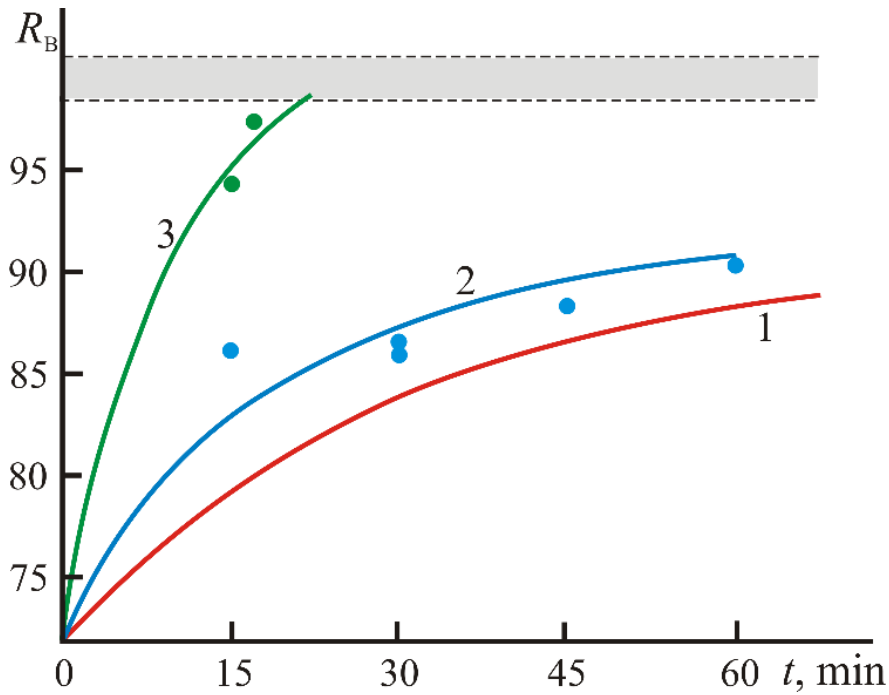
Figure 8. Dispersion strengthening curves for KhN80T alloy for different regimes of ageing: standard (static) ageing at 700 ◦ C (1), 700 ◦ C with UST at σ 0 = 25 MPa (2), 700 ◦ C with UST at σ 0 = 35 MPa (3); the grey bar represents the interval of hardness which is reached by standard ageing at 700 ◦ for 16 h (adapted from [63]).